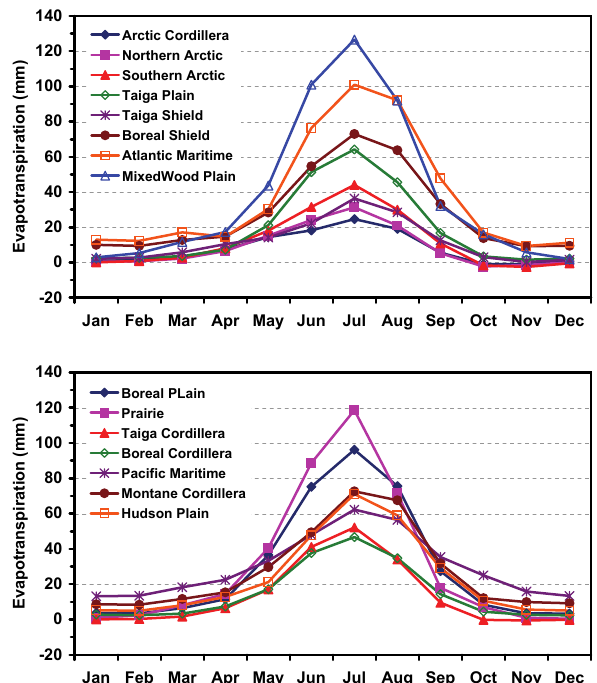
Fig. 13. Seasonal variations of the average evapotranspiration over each of the 15 ecozones in Canada.